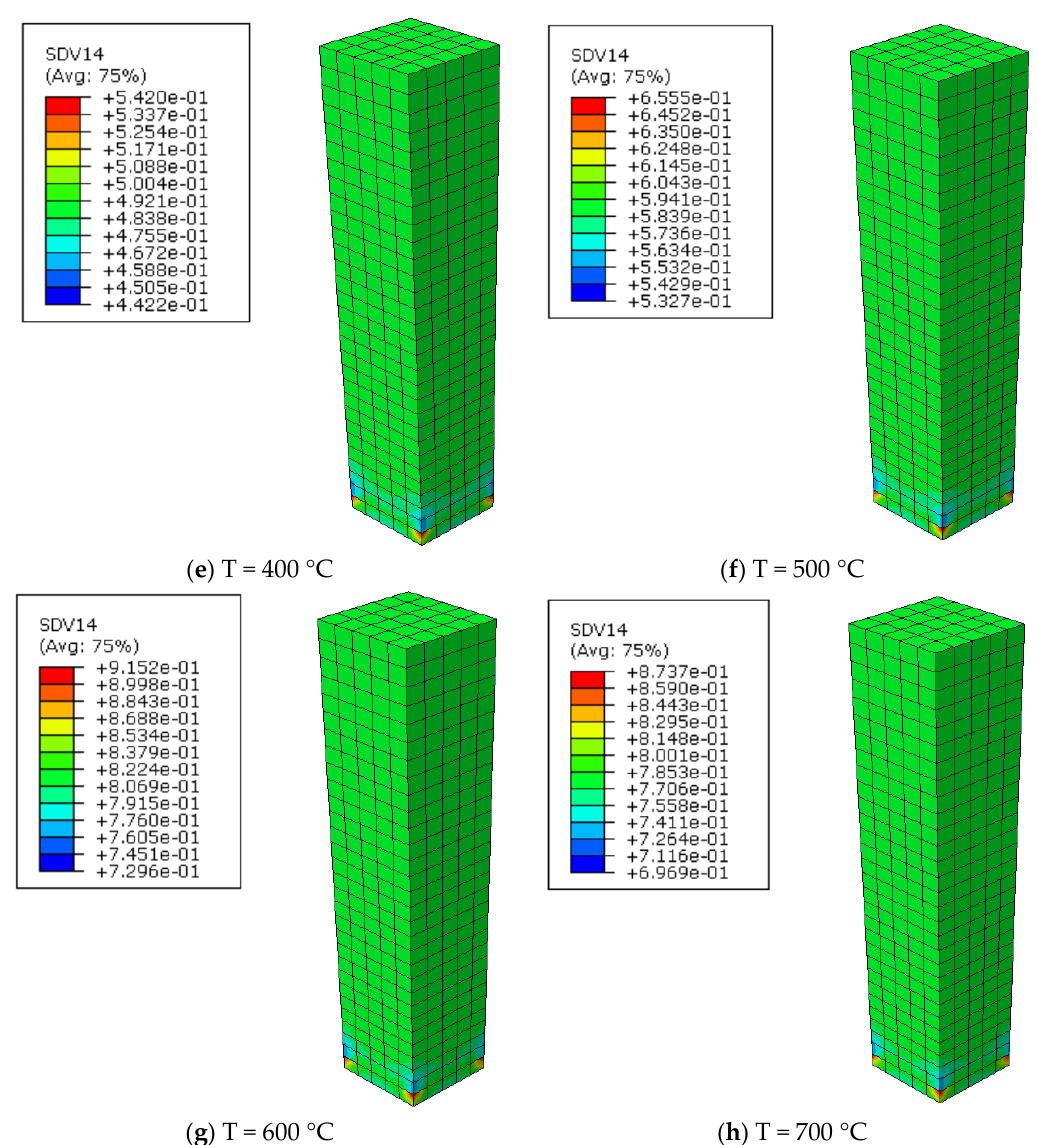
Figure 10. Damage nephograms of axially compressive concrete column at different temperatures.